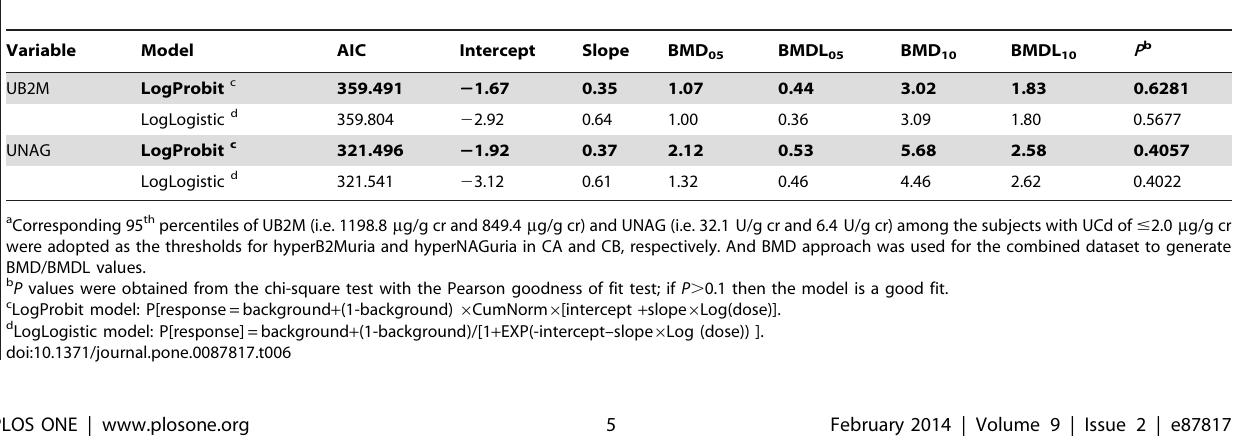
and in humans with a wide range of exposure to Cd [32,33,36].